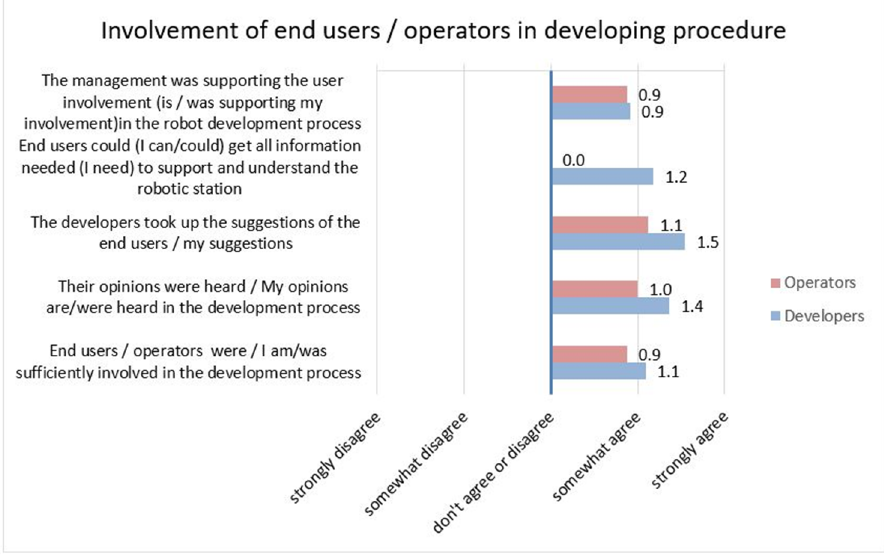
Figure 10. Perceived involvement in the social innovation process. (Average of the answers within a 5-point scale, from −2 strongly and −1 somewhat disagree over 0 do not agree or disagree to +1 somewhat agree to +2 strongly agree).